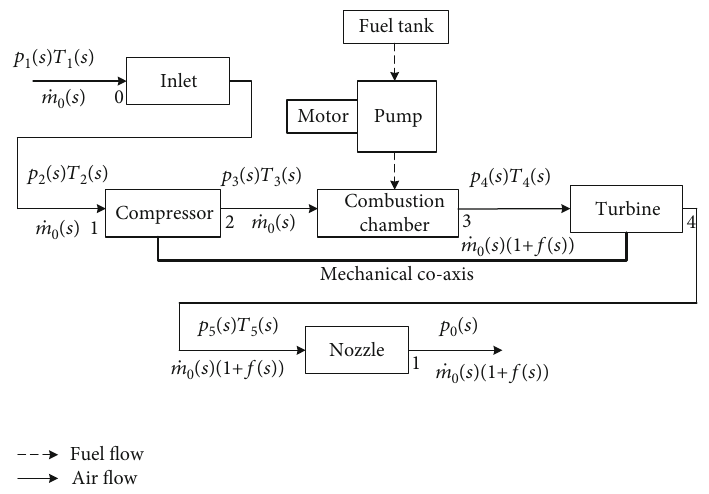
Figure 2: The general operation fl owchart of an aircraft engine.